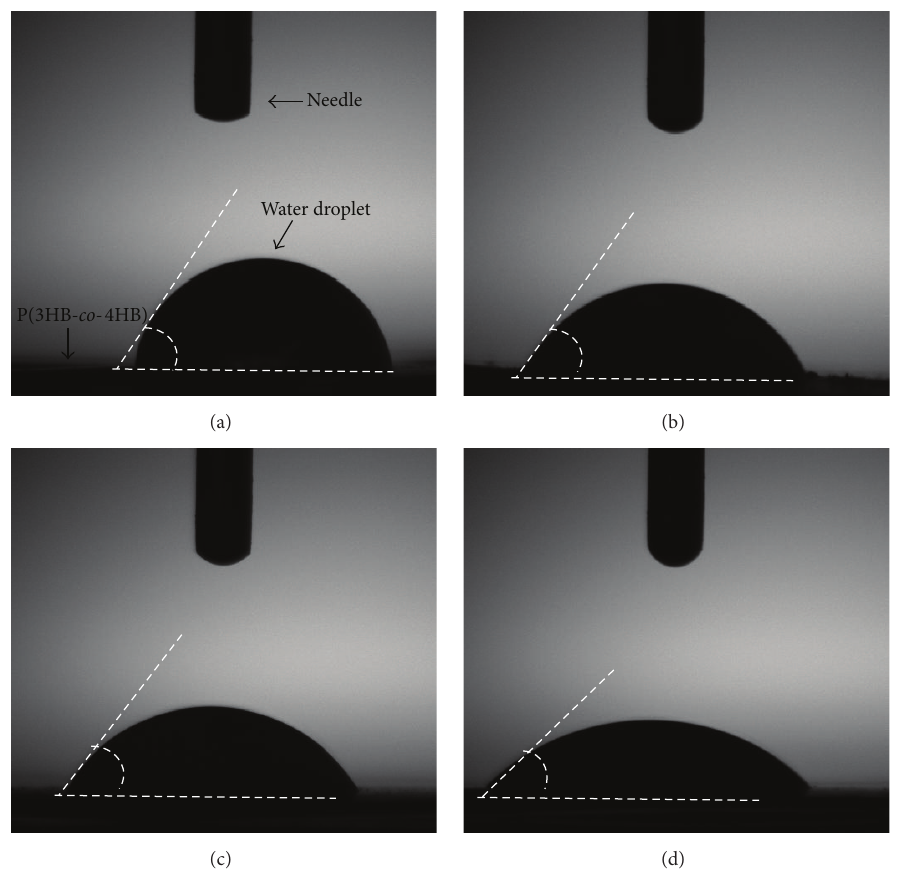
Figure 3: Sessile drops for static water contact angle measurement of 0.1mm thick (a) P(3HB- co -50mol% 4HB) (control) [73.2 ∘ ], (b) P(3HB- co -50mol% 4HB)/5mg collagen [68.9 ∘ ], (c) P(3HB- co -50mol% 4HB)/10mg collagen [64.6 ∘ ], and (d) P(3HB- co -50mol% 4HB)/15mg collagen [44.5 ∘